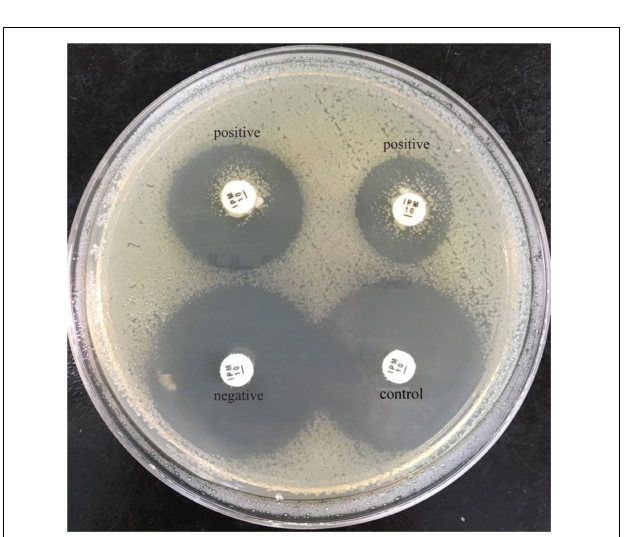
FIGURE 3 | Results of sCIM testing of gram-negative bacilli. Positive isolates (the left is a P. aeruginosa producing VIM-4; the right is an A. baumannii producing OXA-23) demonstrate satellite growth within the zone of inhibition around the